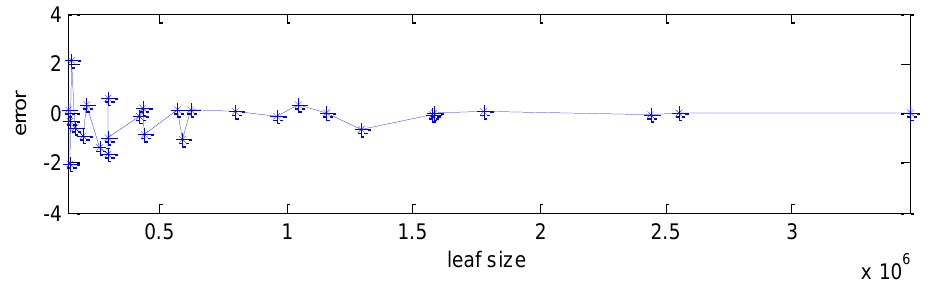
Figure 16. Error in the estimated NBL compared with the leaf